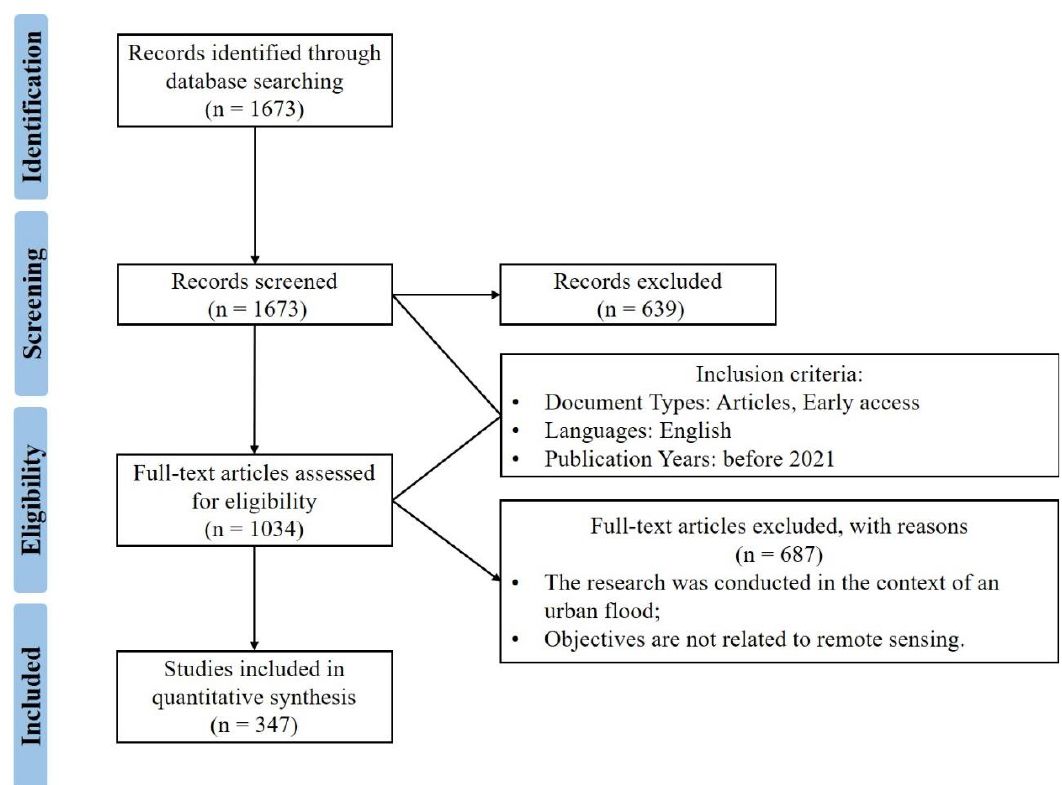
Figure 1. PRISMA flow diagram.